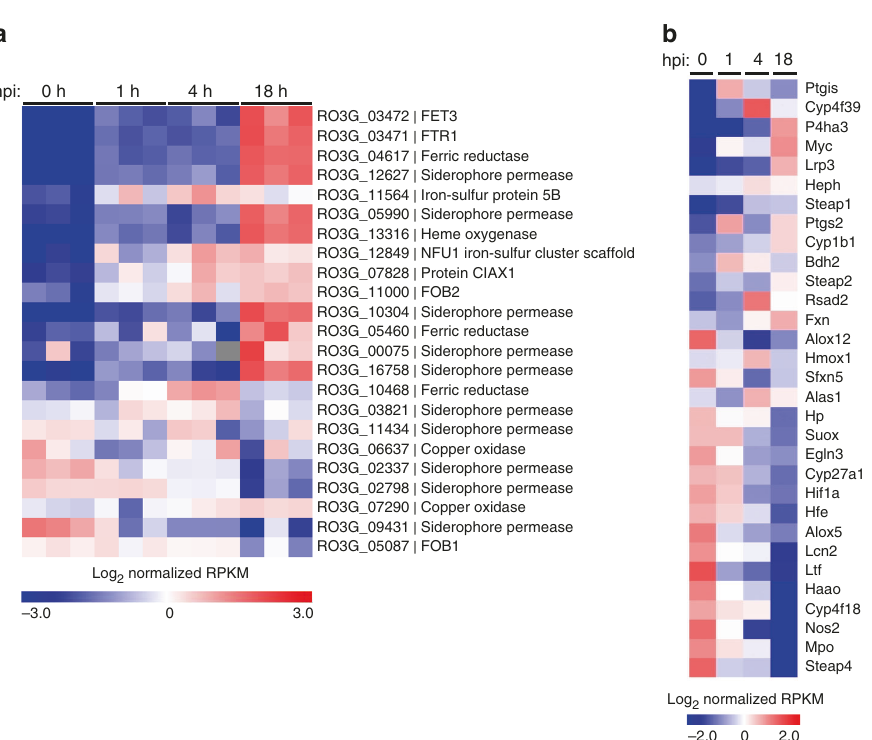
Fig. 7 Global analysis of differential gene expression during infection. RNA-seq-based expression analysis of iron-related a R. delemar genes and b mouse genes following in vitro infection of BMDMs. a Each column represents an individual sample (biological triplicates of four different conditions; n = 12). Log- transformed absolute expression normalized across all samples. Red indicates high gene expression. Blue indicates low gene expression. For the 0 h column, R. delemar was incubated in tissue culture media without BMDMs for 1 min. b Values are presented as in a and represent the average of three biological replicates for each condition. For the 0 h columns, BMDMs were incubated in culture media in the absence of R. delemar spores for 1